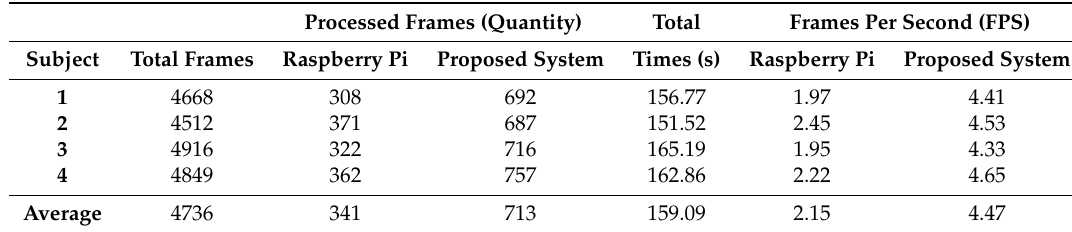
Table 4. Comparison of the processing